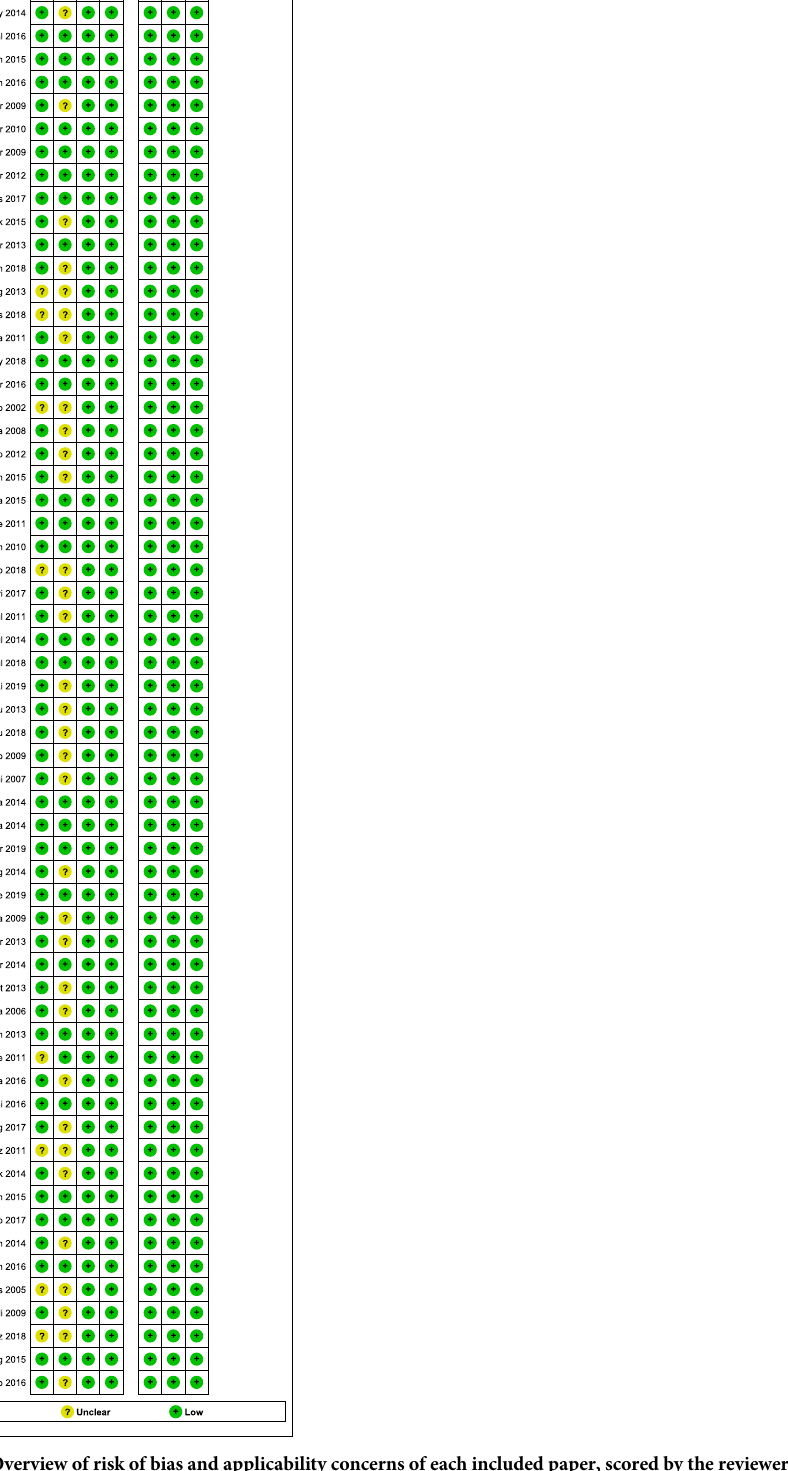
Fig 6. Overview of risk of bias and applicability concerns of each included paper, scored by the reviewers using QUADAS-2 analysis. QUADAS = Quality Assessment of Diagnostic Accuracy Studies. https://doi.org/10.1371/journal.pone.0232856.g006 PLOS ONE | https://doi.org/10.1371/journal.pone.0232856 May 6,